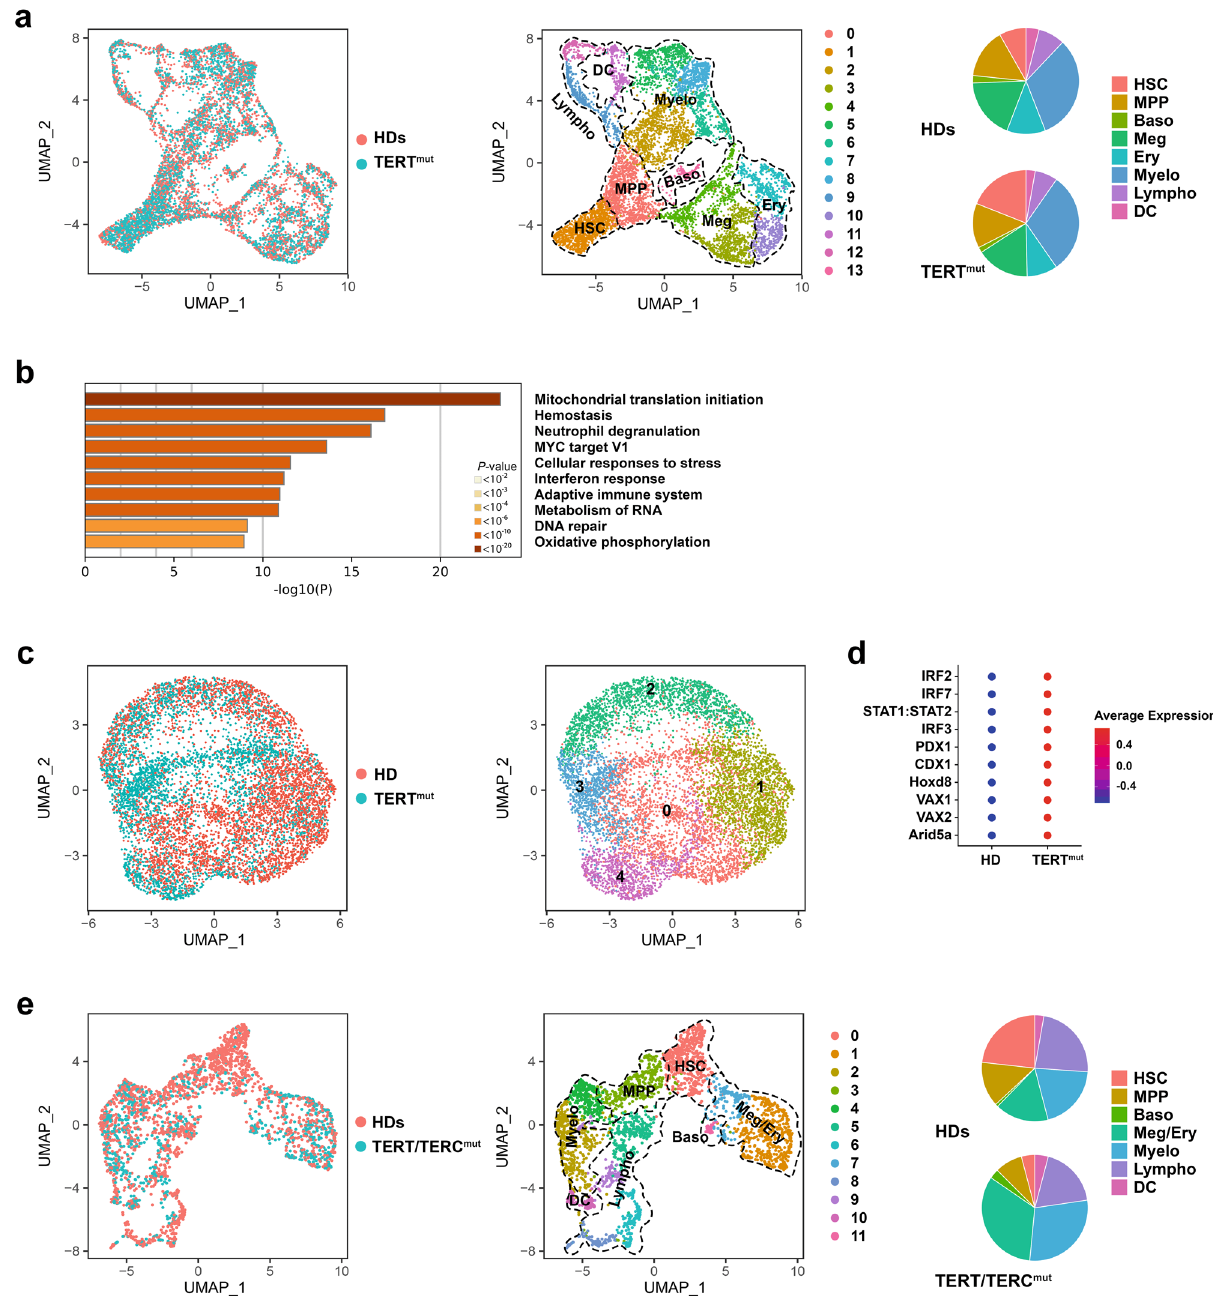
Fig. 5 The functional link among telomere shortening, IFN signaling activation, and HSC differentiation towards the megakaryocyte lineage is conserved in humans. a UMAP of scRNA-seq data displaying single Lin − CD34 + cells isolated from two healthy donors (HDs; n = 3800) and two individuals with a pathological TERT mutation ( TERT mut ; n = 4105). Each dot represents one cell. The sample origin (left) and cluster identity (middle) of each cell are indicated by different colors. Right, distribution of the HD and TERT mut Lin − CD34 + cells among clusters de fi ned by distinct lineage differentiation pro fi les. b Pathway enrichment analysis of signi fi cantly upregulated genes in TERT -mutant HSCs from cluster 1 shown in Fig. 5a as compared with those of HDs (adjusted P ≤ 0.05). The top ten Hallmark and Reactome gene sets are shown. c UMAP of scATAC-seq data displaying 4546 and 3489 single Lin − CD34 + cells isolated from one HD and one individual with a pathological TERT mutation, respectively. Each dot represents one cell. The sample origin (left) and cluster identity (right) of each cell are indicated by different colors. d Dot plot of the level of activities of the top ten TFs whose binding sites were signi fi cantly enriched in the open chromatin regions of TERT -mutant cells from cluster 3 shown Fig. 5c as compared to those enriched in the open chromatin regions of HD cells. e UMAP of scRNA-seq data displaying single Lin − CD34 + cells isolated from two HDs ( n = 1958 cells) and two patients with pathogenic telomerase complex mutations and severe BM failure syndrome ( TERT / TERC mut ; n = 856 cells). Each dot represents one cell. The sample (left) and cluster (middle) identities are indicated by different colors. Right, the distribution of the HD and Lin − CD34 + cells among clusters is de fi ned by distinct lineage differentiation pro fi les. HSC hematopoietic stem cell, MPP multipotent progenitor, Baso basophil, Meg megakaryocytic, Ery erythroid, Myelo myeloid, Lympho lymphoid, DC dendritic cells. Source data are provided as a Source Data fi